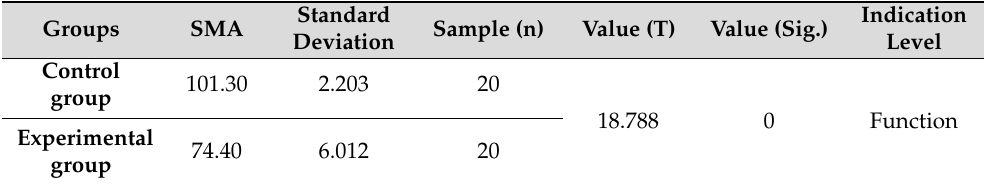
Table 4. Significance of differences between experimental and control group averages in post- application of performance test for skills of practical experiments.